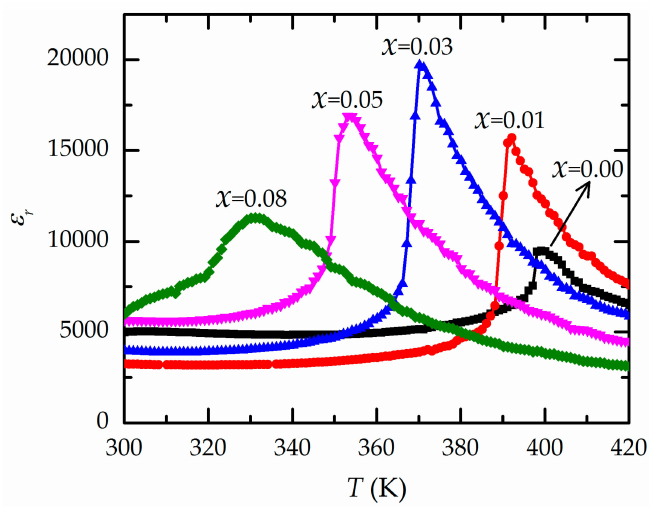
Figure 4. Relationships between the dielectric constant ( ε r ) and temperature for all samples of Ba(Zr x Ti 1 − x )O 3